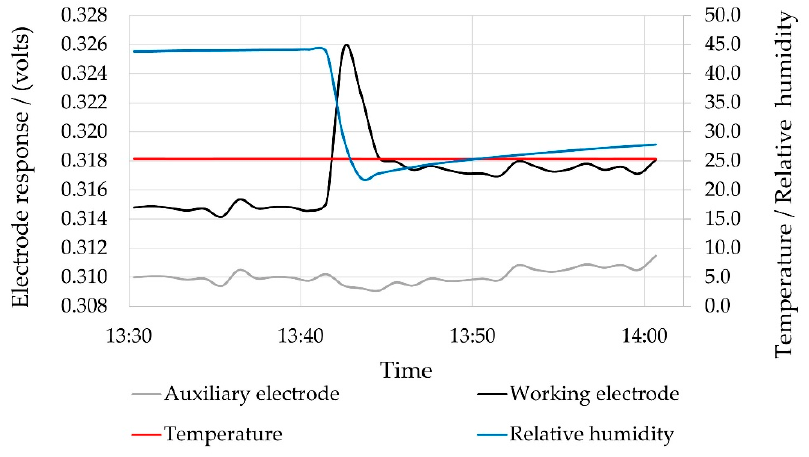
Figure 3. Working electrode responses to humidity transient.